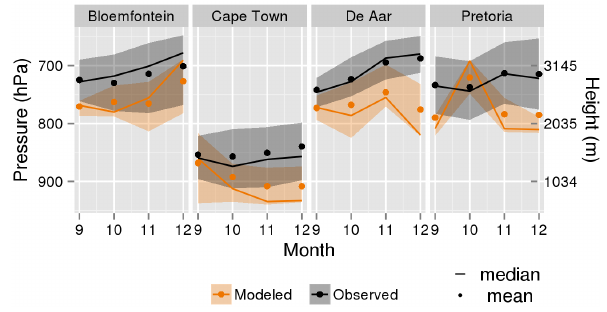
Figure 4. Inversion heights for each month (September–December) and four different radiosonde stations, lines represent the median, shaded areas the 25th and 75th percentiles, dots the mean values.